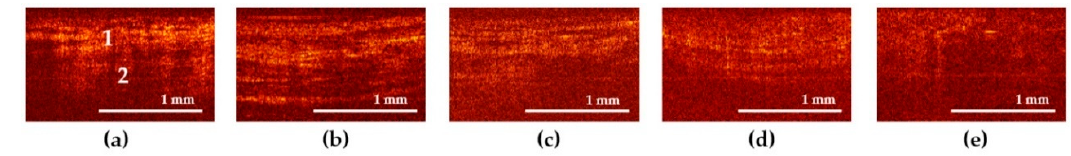
Figure 2. Typical cross-polarization OCT images of the bladder mucosa in the studied patients’ groups: ( a ) “normal” group; ( b ) “chronic cystitis” group; ( c ) “Grade 2 radiation cystitis” group; ( d ) “Grade 3 radiation cystitis” group; ( e ) “Grade 4 radiation cystitis” group. 1 – mucosa and submucosa layers, 2 – muscular layer.